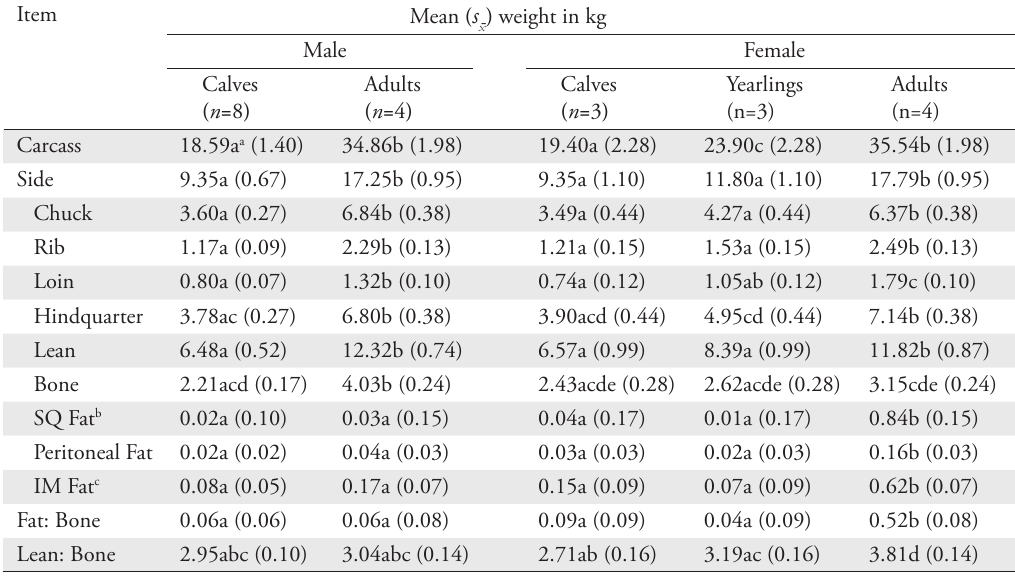
mined using an Instron Universal Testing Machine. Table 1. Mean (standard error of the mean s ) carcass, side and primal weights of male and female reindeer calves, x - yearlings, and adults slaughtered in January, 1993 on Nunivak Island,